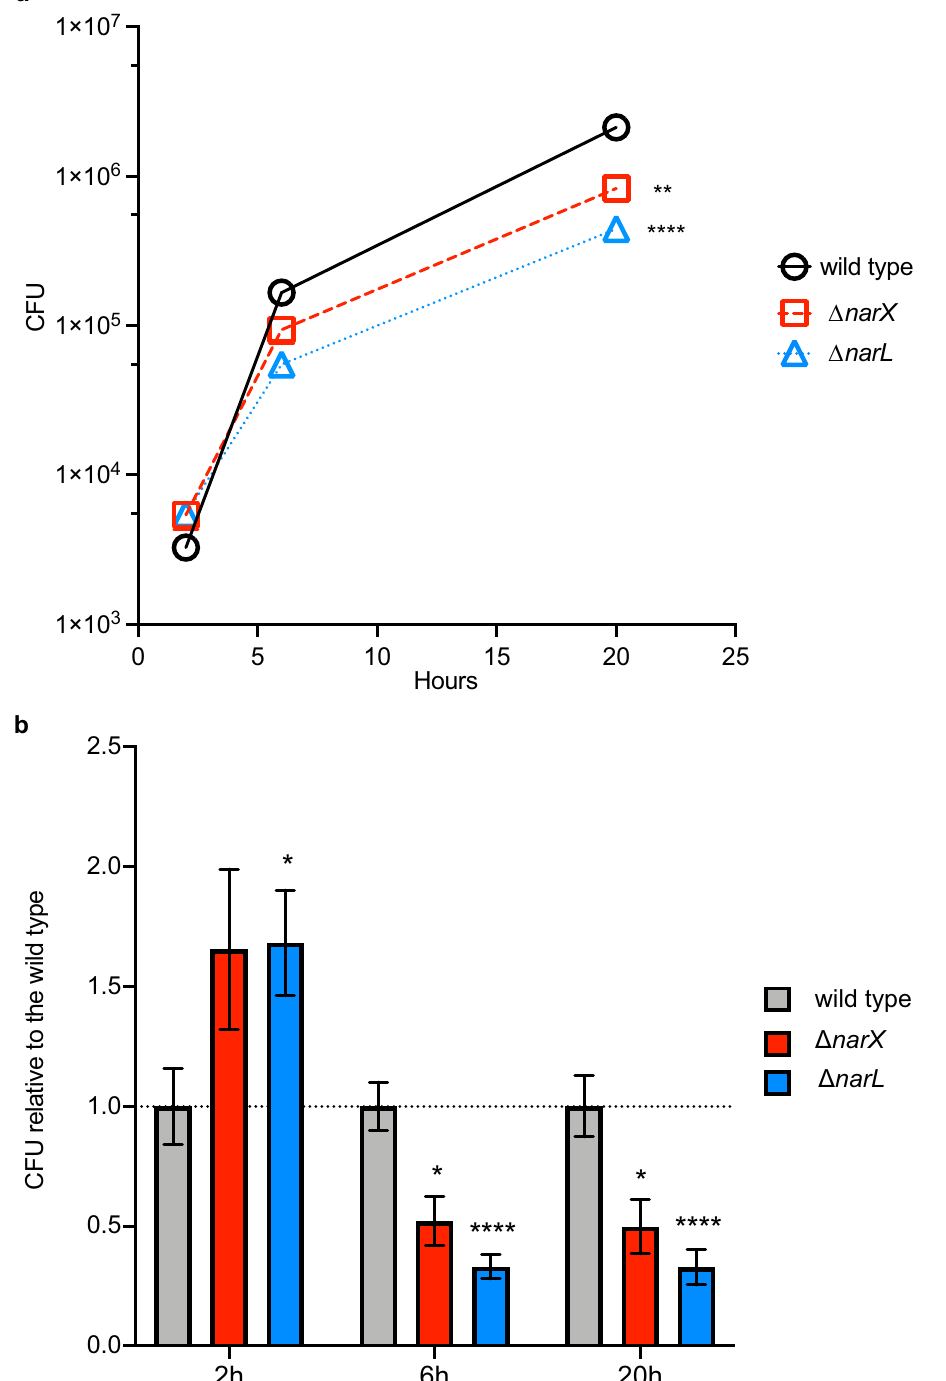
Figure 5. B. pseudomallei mutants lacking NarX and NarL are deficient in intracellular replication despite being internalized at a higher rate than the wild type. RAW264.7 cell monolayers were infected at an MOI of ~ 2 with three strains (wild type, ∆ narX , and ∆ narL ) and intracellular survival was measured at 2 h, 6 h, and 20 h post- infection. At 1 h post-infection, cells were treated with 750 μg/mL kanamycin to kill extracellular bacteria. Total CFU levels were calculated ( a ) as well as CFU relative to the wild type ( b ) at all time-points. The internalization efficiency of the mutant is evident at 2 h post-infection, yet the intracellular replication efficiency is hindered at 6 h and infection is attenuated at 20 h ( b ). Wild type is depicted in black ( a ) or grey ( b ), with ∆ narX in red and ∆ narL in blue throughout. Statistical significance was determined using the Holm-Sidak method across multiple Student’s T-tests (*p < 0.05, **p < 0.01, ****p < 0.001), whereby each mutant is compared to the wild type at all time points